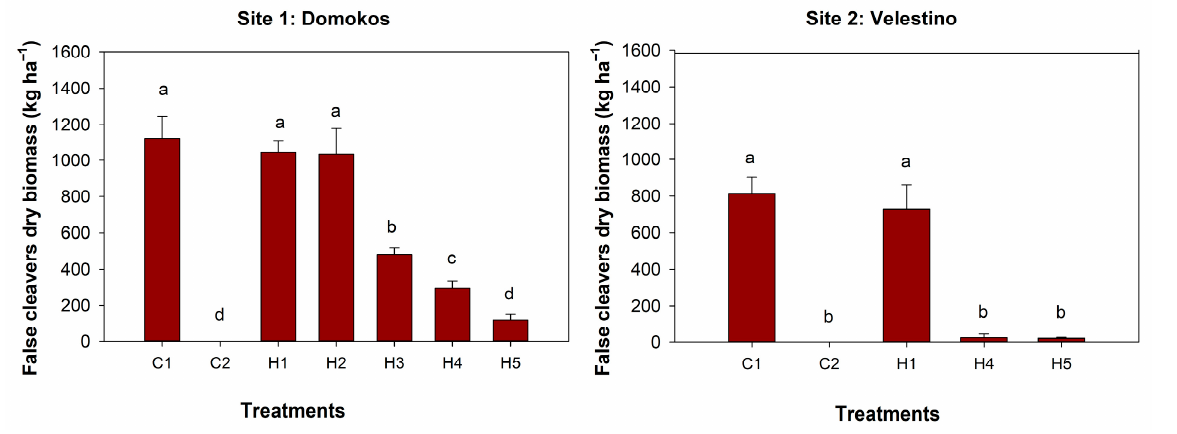
Figure 2. Herbicide treatment (C1: untreated control, C2: weed-free control, H1: metsulfuron-methyl + bensulfuron-methyl, H2: pyroxsulam/florasulam + 2,4-D, H3: aminopyralid + florasulam, H4: bromoxynil + 2,4-D, and H5: halauxifen-methyl + florasulam) effects on false cleavers dry biomass (kg ha − 1 ) at two sites. Values are presented as means of three replicates ± standard deviation. Mean values followed by different letters have statistically significant differences according to Duncan’s multiple range test at p < 0.05. F values of ANOVA: F = 111.567 *** (Site 1: Domokos) and F = 109.565 *** (Site 2: Velestino). *** significant at p < 0.001.